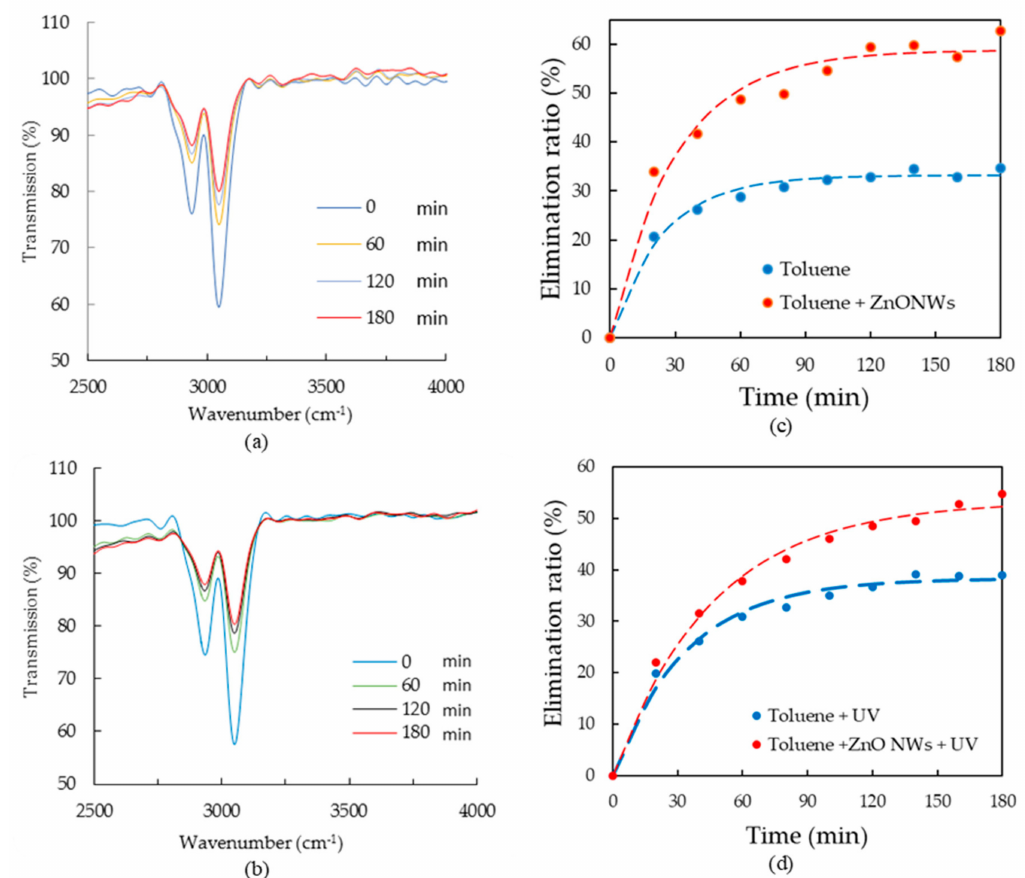
Figure 6. ( a , b ) Transmission of toluene measured using the MEMS spectrometer at di ff erent measurement time ( a ) without and ( b ) with the presence of UV. ( c , d ) The elimination ratio of toluene versus time in case of absence and presence of ZnO ( c ) without and ( d ) with the presence of UV. The elimination ratio is calculated using the gas absorbance at 3042 cm − 1 . Dash lines represent exponential fit for the measured